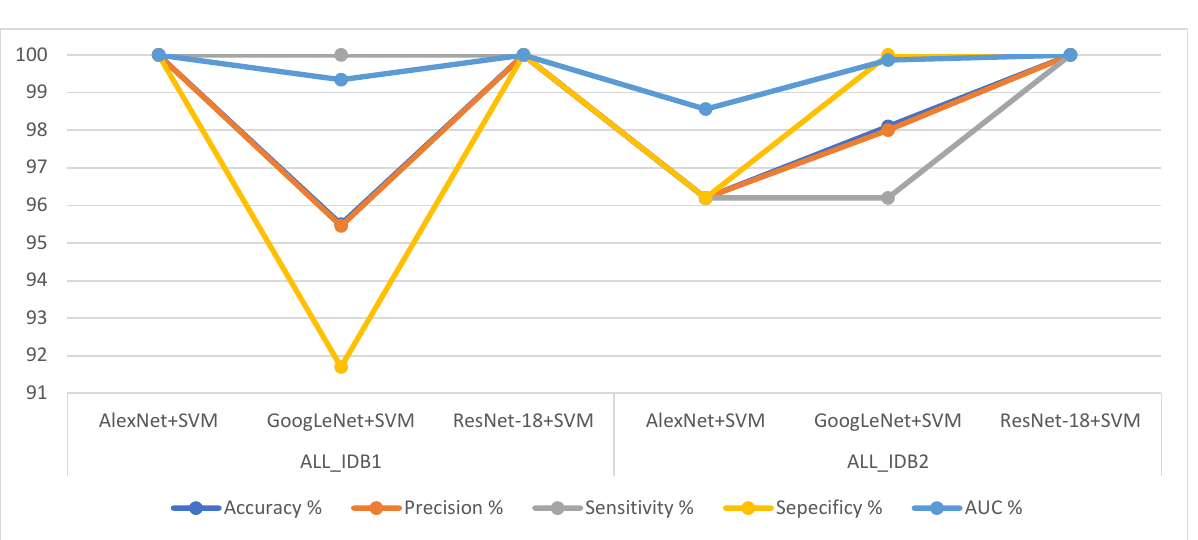
Table 6. The results of the AlexNet, GoogLeNet and ResNet-18 models on the ALL_IDB1 and ALL_IDB2 datasets.